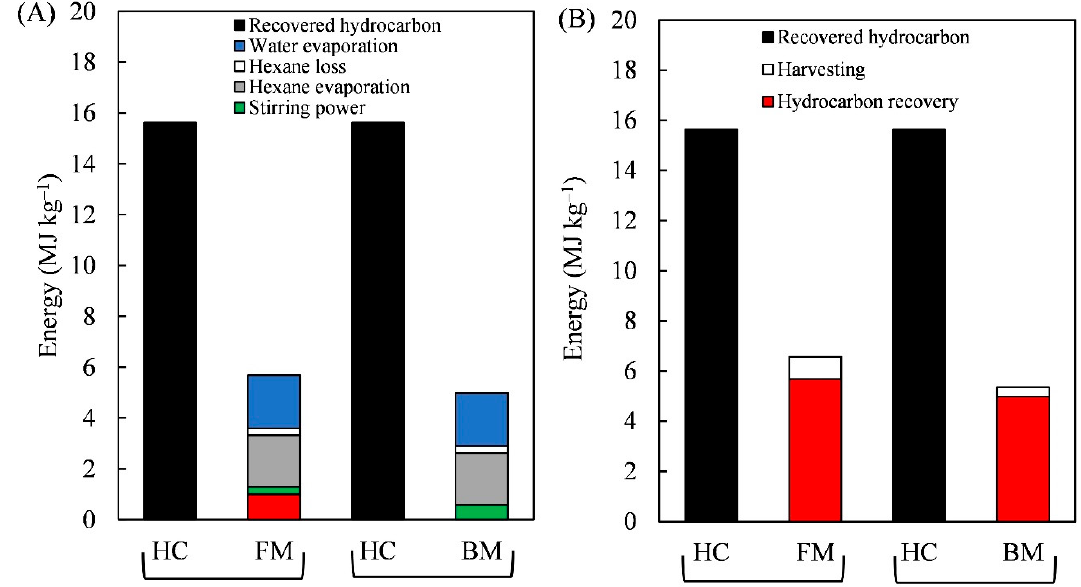
Figure 7. Input energy per unit of dry algae of hydrocarbon recovery ( A ) and the process from harvesting to hydrocarbon recovery ( B ) from algae cultured in different media. HC: Hydrocarbon, FM: Freshwater medium, BM: Brackish medium.